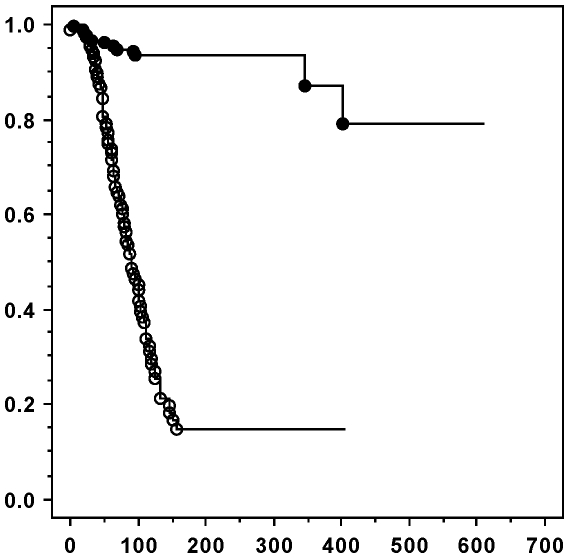
Survival following onset of polydipsia (PD).The survival of PD voles (line with open circles; n = 155) are compared with the survival of NN voles (line with filled circles; n = 178) after age 60 days. Each circle signifies an event of “natural death” (90 among PD; 13 among NN). The abscissa denotes ages in days and the ordinate denotes the fraction of survivors.